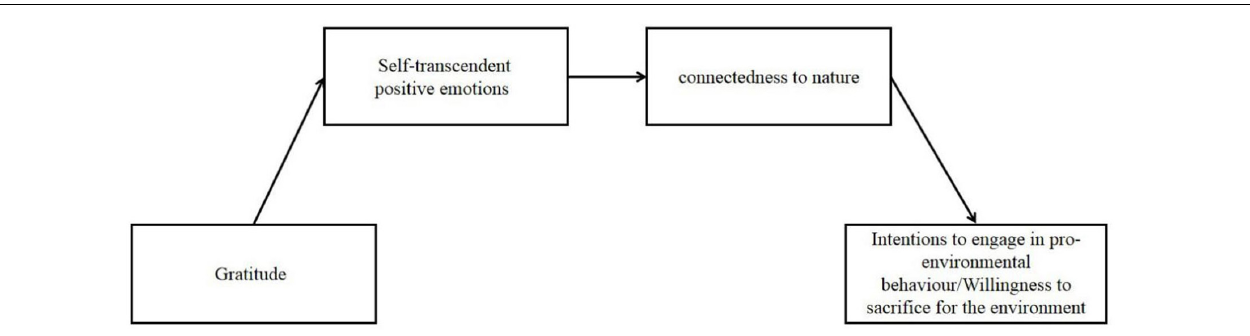
FIGURE 2 | A conceptual model of gratitude indirectly influencing pro-environmental tendencies through positive emotions of self-transcendence and a connection to nature.